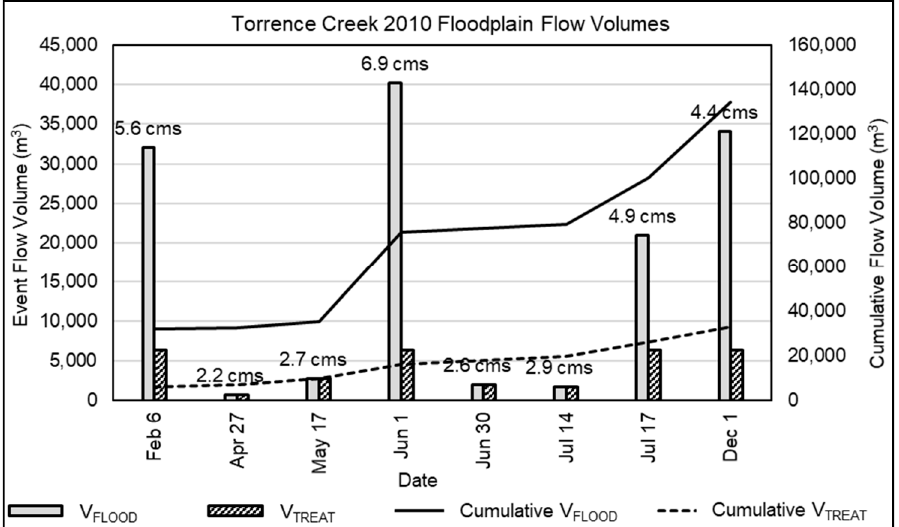
Figure 5. Cumulative and event volume for Torrence Creek in 2010. The maximum discharge for each event is also shown.